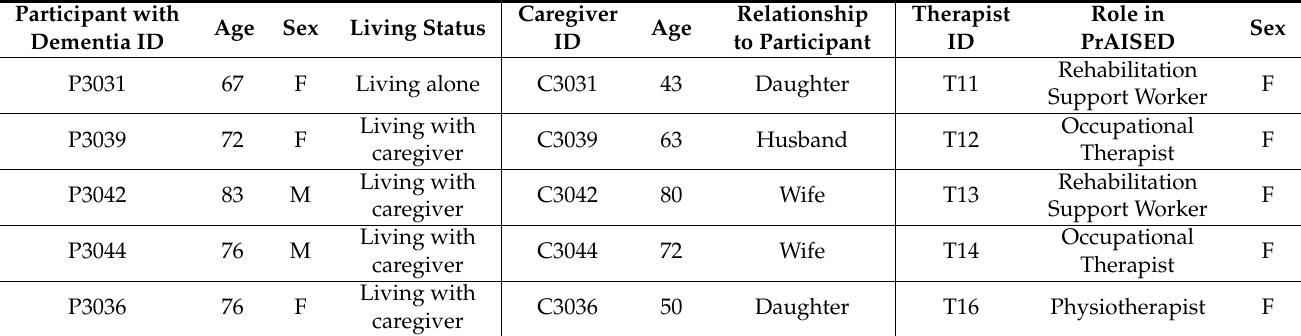
Table 1. Characteristics of